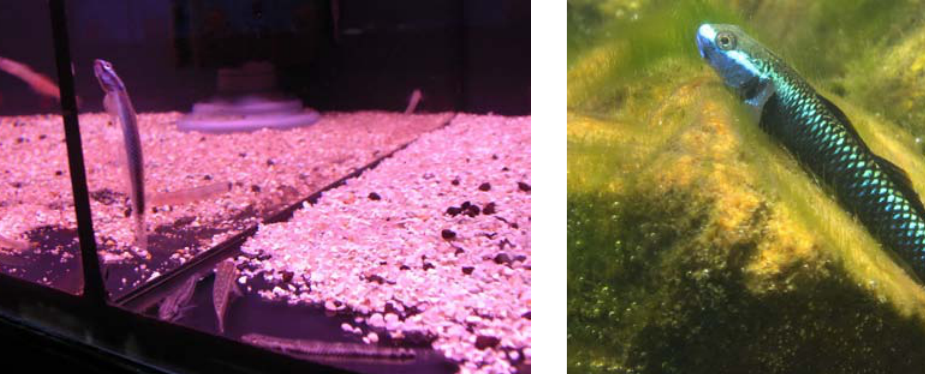
Image 1. Sicydiine gobies ( Stiphodon atropurpureus and Sicyopus zosterophorum ) in the tanks of a pet